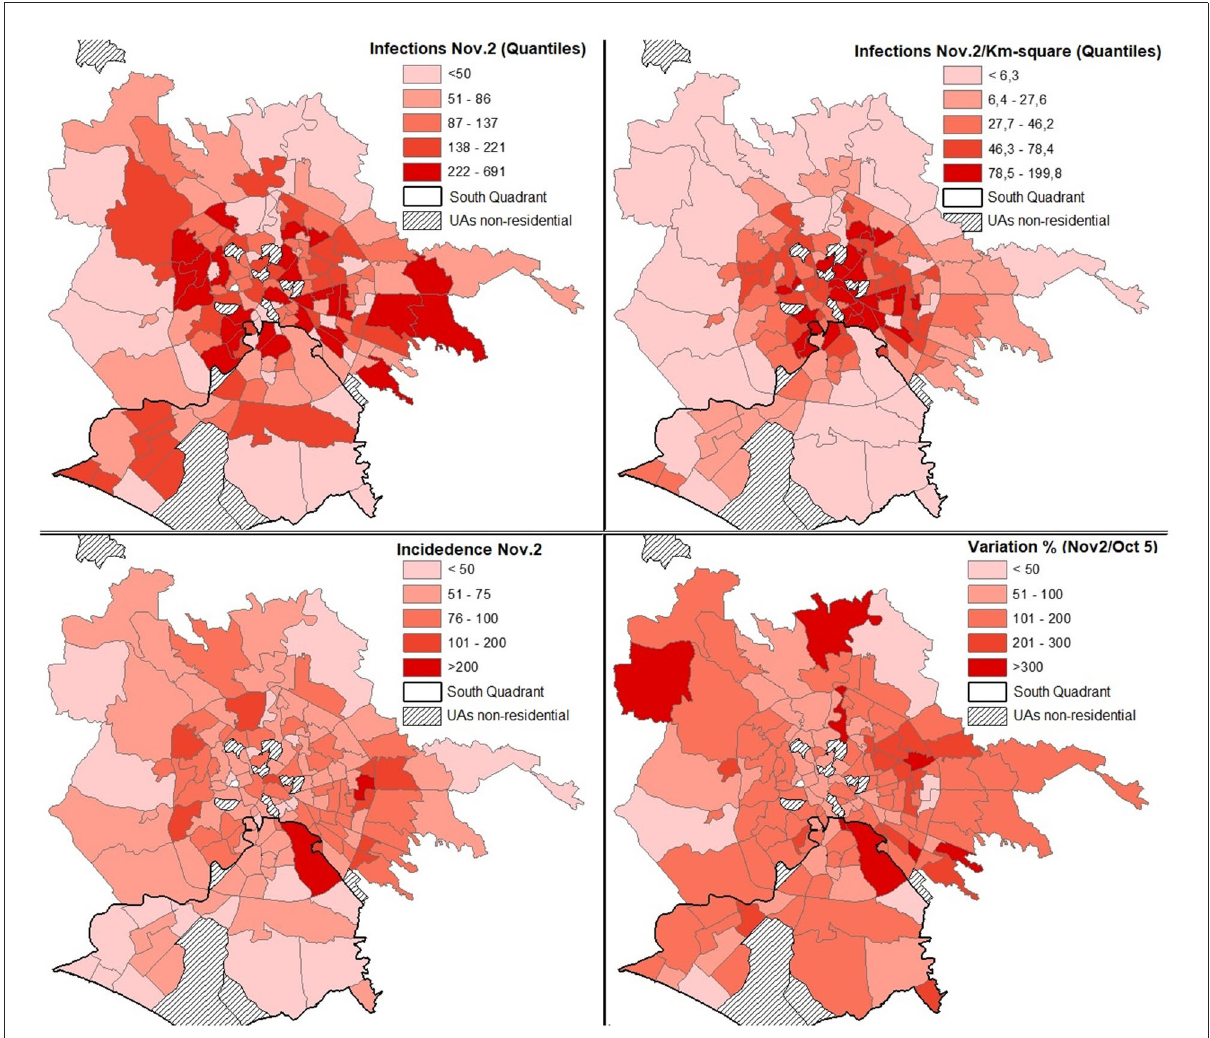
FIGURE2 Territorial configuration of the infection indexes as of November 2,